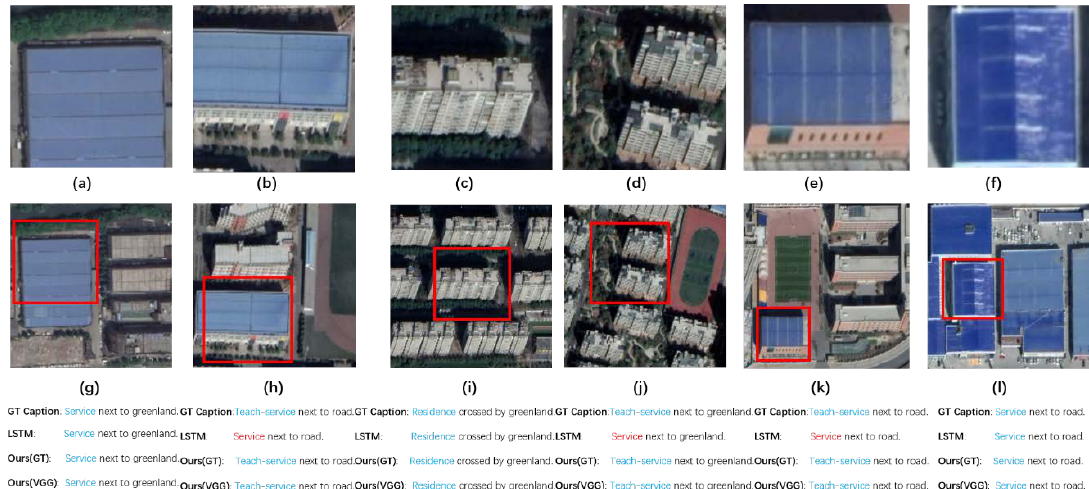
Figure 8. Demonstration of three networks’ performance on ‘fake conflict’ samples. ( a – f ) are four small-scale samples; ( g – l ) are corresponding large-scale samples of ( a – f ); ( a , b ) are a pair of ‘fake conflict’ sample; ( c , d ) are a pair of ‘fake conflict’ sample; ( e , f ) are a pair of ‘fake conflict’ sample. The